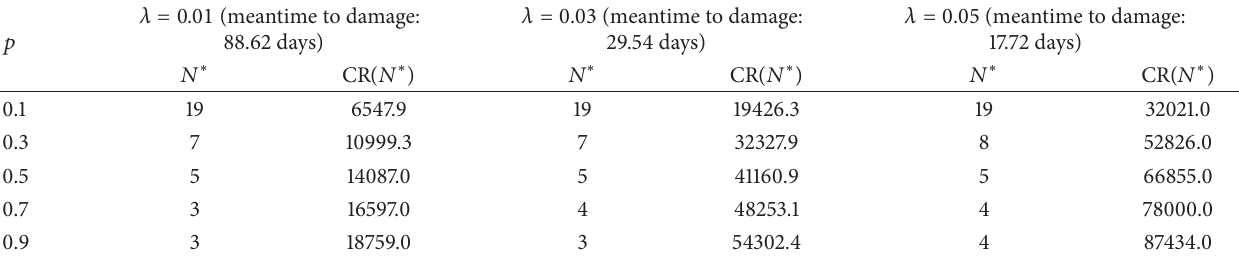
Table 3: Sensitivity analysis for 𝜆 .